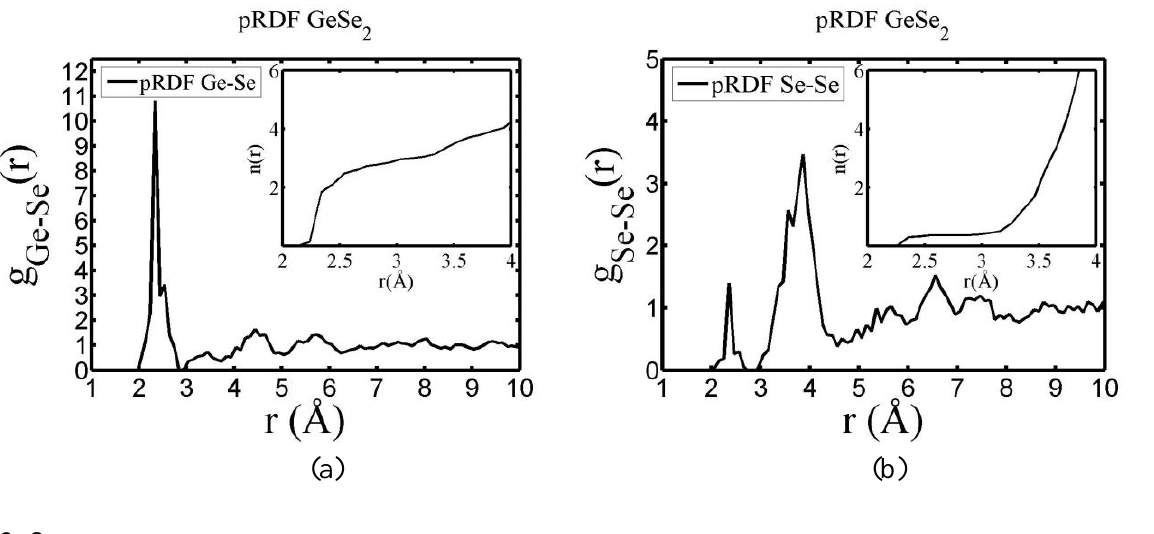
Figure 25. ( a ) Partial Ge–Se RDF for the system a -GeSe same system. Insets show the corresponding average coordination